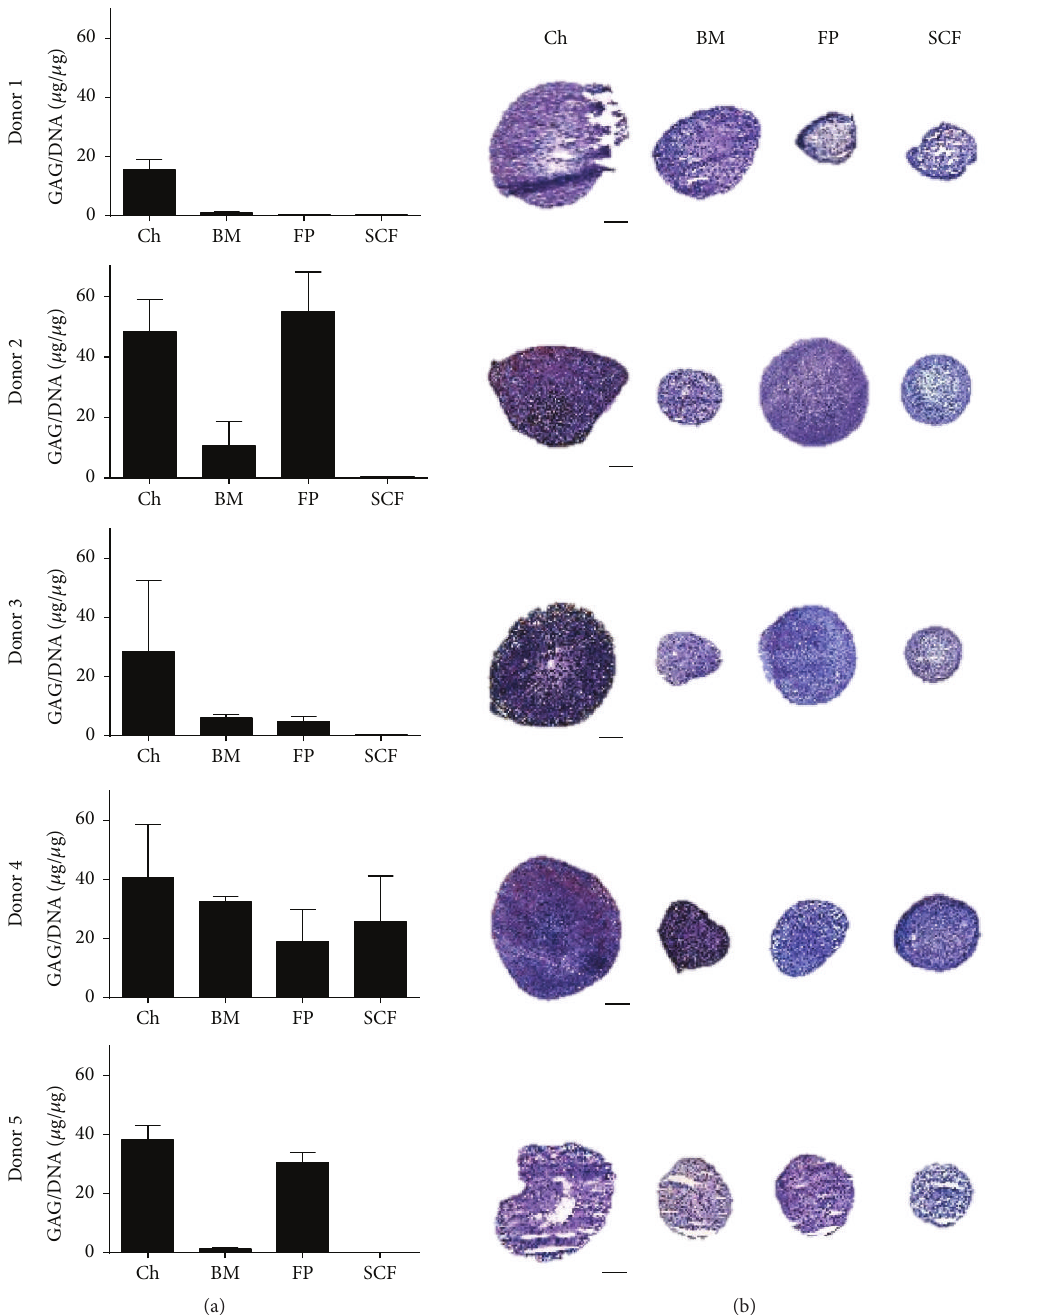
Figure 3: Chondrogenic assessments of pellet cultures between donors. (a) Production of GAG/DNA in pellet cultures from chondrocytes (Ch), bone marrow MSC (BM), fat pad MSC (FP), and subcutaneous fat MSC (SCF). GAGs were measured after chondrogenic differentiation using the DMMB assay and normalised to the DNA content of pellets; each donor is represented in individual graphs. Data shown are the means ± the standard deviation of triplicate pellets. (b) Chondrogenic pellets from Ch, BM, FP, and SCF showing representative toluidine blue staining for each donor. Scale bars represent 200 𝜇